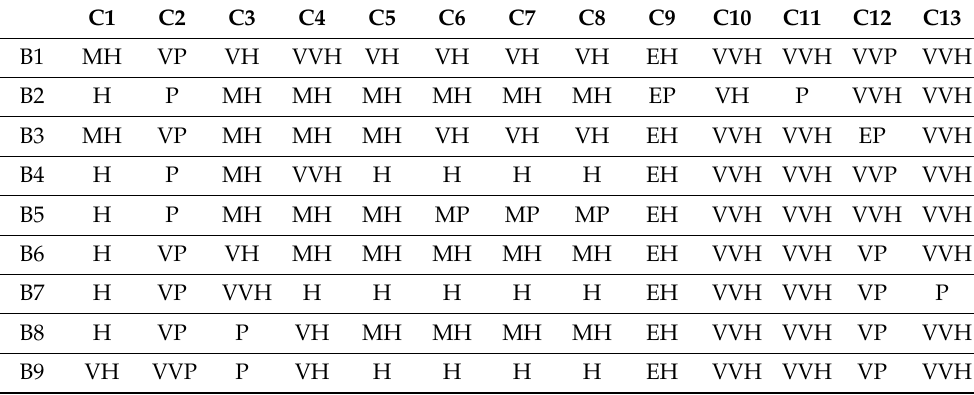
Table A3. Assessment of alternatives by